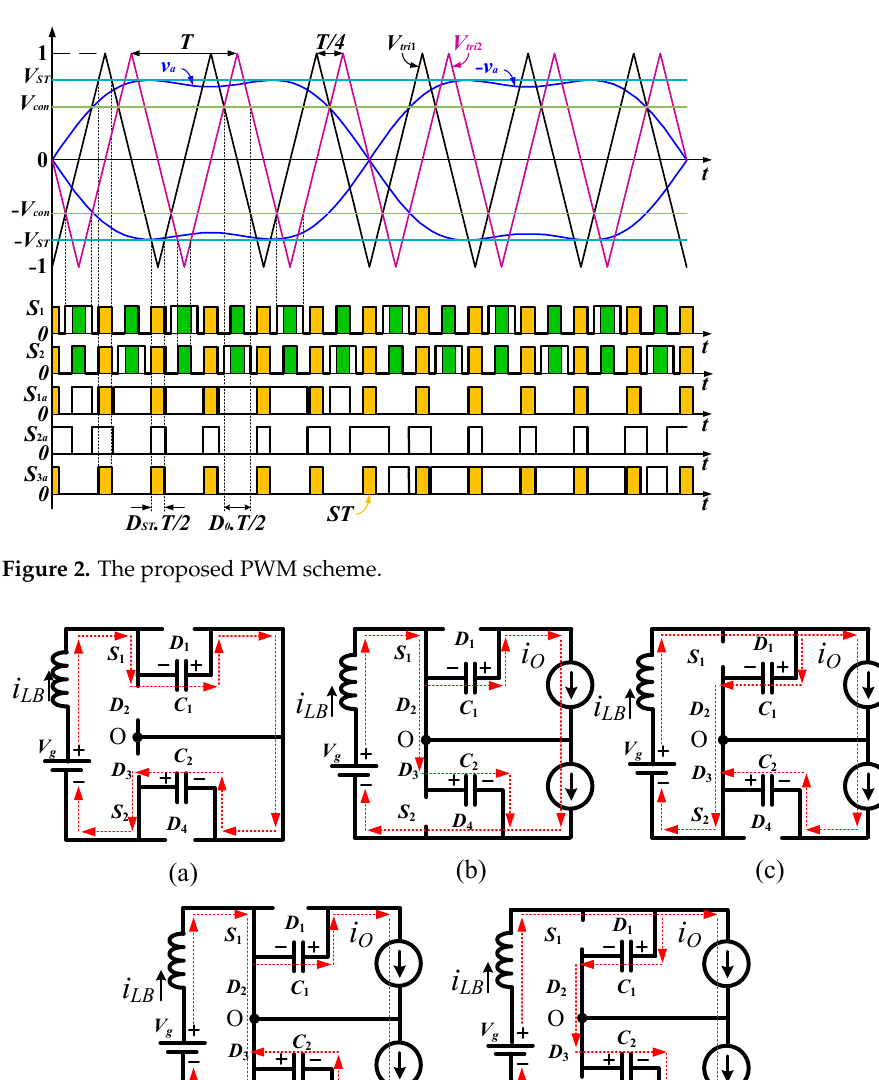
Figure 2. The proposed PWM scheme.